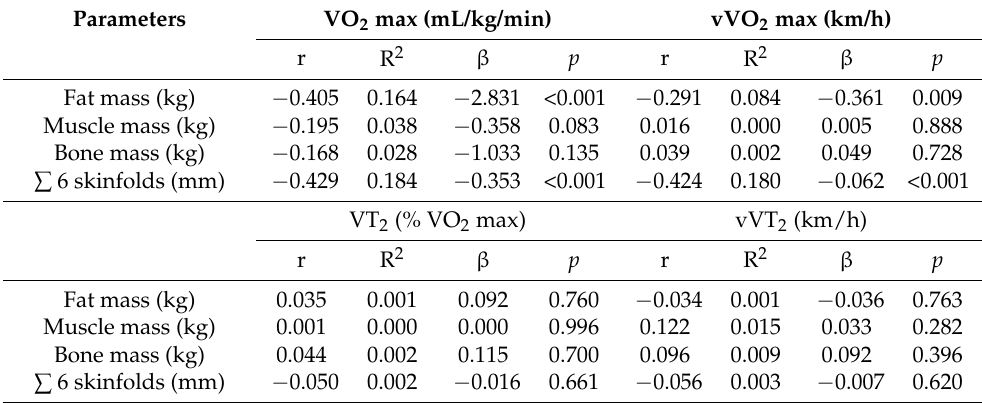
Table 5. Simple linear regressions between performance parameters and anthropometric values. Parameters